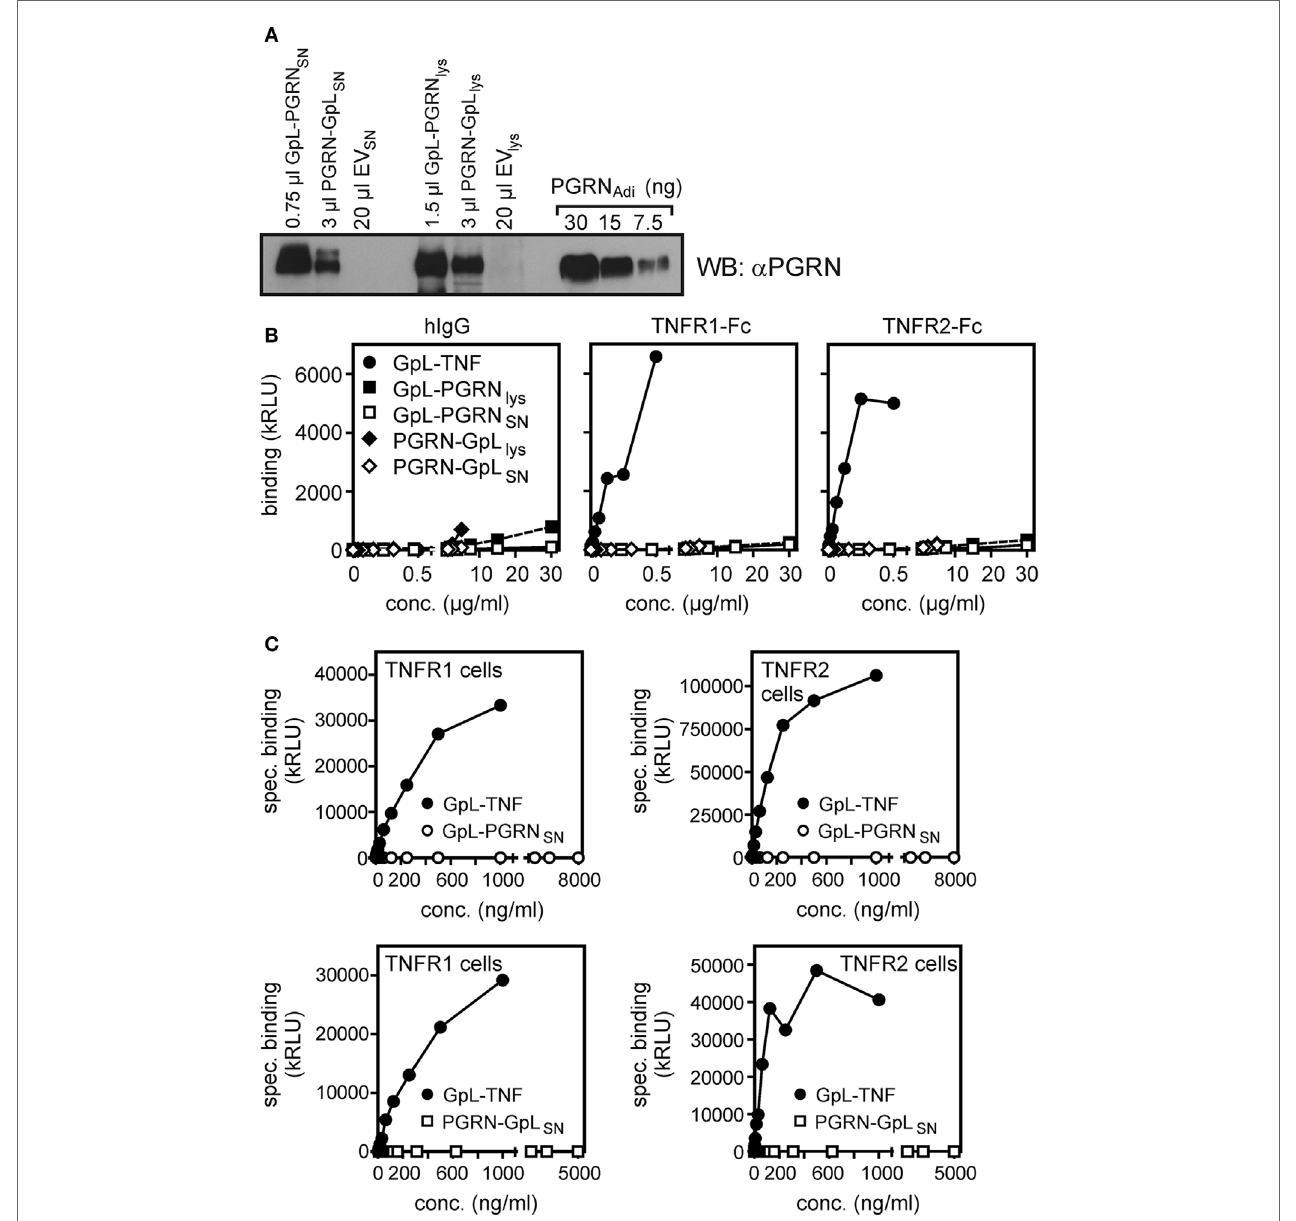
FigUre 4 | Gaussia princeps luciferase (GpL) fusion proteins of progranulin (PGRN) show no relevant binding to tumor necrosis factor receptor-1 (TNFR1) or TNFR2. (a) Human embryonal kidney cells 293 (HEK293) cells were transiently transfected with expression plasmids encoding GpL-PGRN (GpL-PGRN), PGRN-GpL (PGRN-GpL), or empty vector (EV). GpL-PGRN concentrations in supernatants (SNs) and cell lysates were determined by help of a GpL fusion protein of known concentration. SNs and cell lysates, containing approximately 100 ng PGRN-GpL or GpL-PGRN along with 100 ng PGRN Adi , were subjected to Western blotting with a PGRN-specific antibody to verify the integrity of the PGRN GpL fusion proteins. (B) TNFR1-Fc, TNFR2-Fc or, as a control for unspecific binding, hIgG1 were immobilized to black enzyme-linked immunosorbent assay plates. Lysates and SN of the GpL-PGRN (GpL-PGRN lys and GpL-PGRN SN ) and PGRN-GpL (PGRN-GpL lys and PGRN-GpL SN ) transfected cells and GpL-tumor necrosis factor (TNF) were added for 1 h and binding was determined in triplicates. (c) TNFR1 and TNFR2 expressing transfectants (total binding) and EV-transfected HEK293 cells (non-specific binding) were subjected to equilibrium binding studies with the indicated GpL fusion proteins. Specific binding ( = total − non-specific binding) values were fitted by non-linear regression analysis to a single binding site type of interaction by help of the GraphPad Prism 5 software.